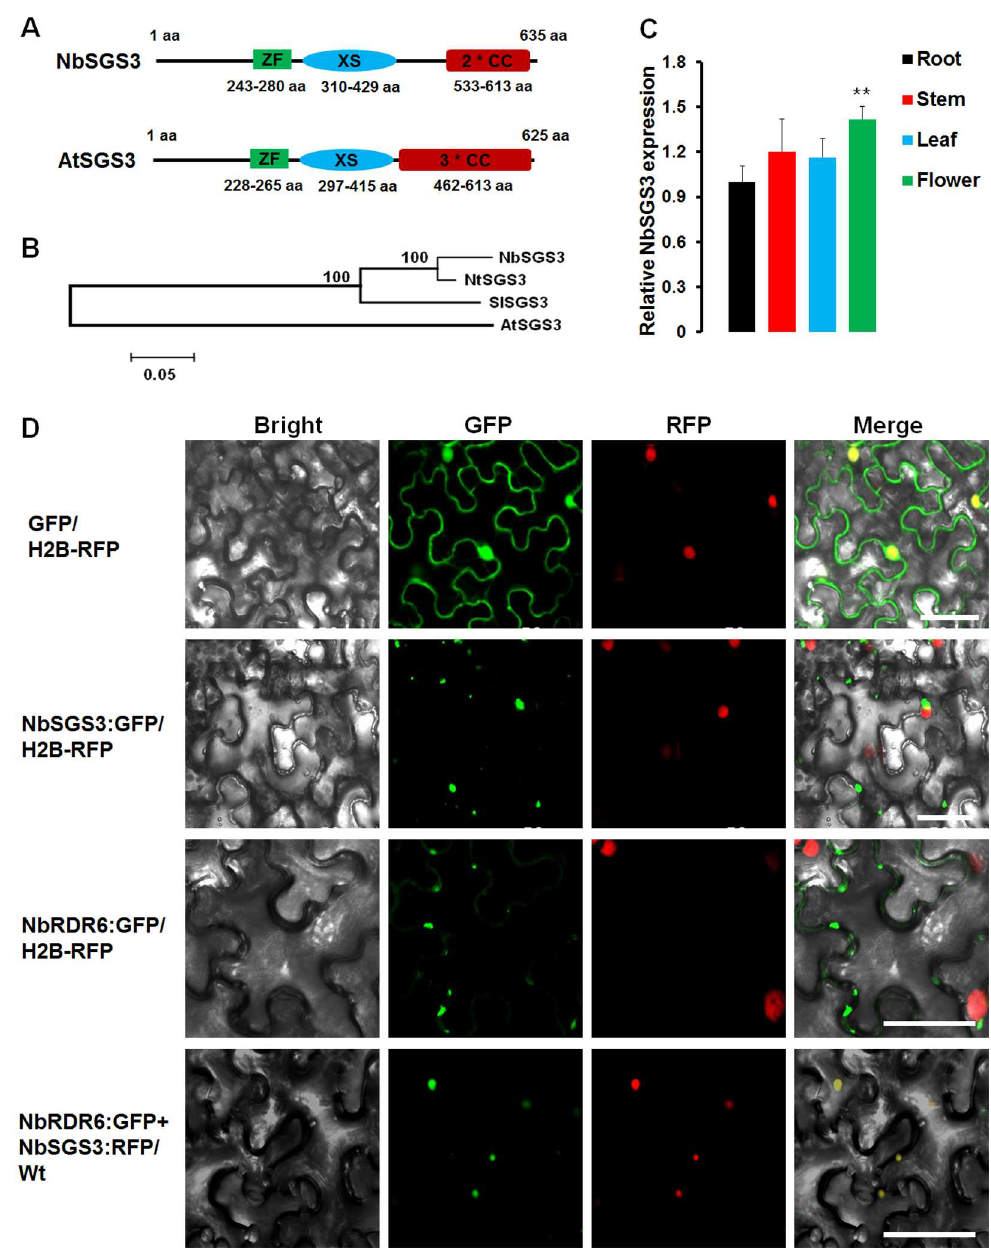
Fig 2. Sequence analysis, expression pattern and subcellular localization of NbSGS3. (A) The lineardiagram representsthe domainstructure of AtSGS3 and NbSGS3, ZF: Zinc finger, XS: Rice proteinX andSGS3, CC: Coiled-coil. (B) Phylogenetic tree showing the evolutionaryrelationships betweenNbSGS3, NtSGS3, SlSGS3 and AtSGS3 proteins.Amino acidsequencealignment was performed in ClustalX2and tree construction was conducted in MEGA6 usingthe NeighbourJoiningmethod. The scalebar representsthe number of changesper site. (C) RT- qPCR analysisof NbSGS3 expression levels in different tissues of N . benthamiana .Expressionwas normalizedto NbGAPDH levels, which serves as an internalstandard. The relativemRNA level of NbSGS3 in root was arbitrarily set to 1. R: Root, S: Stem, L: Leaf, F: Flower. Student’s t test was performedto comparedifferences between root andstem, leaf or flower tissues. Each mean valuewas derivedfrom three independent experiments (n = 9). Values representthe mean ± standarddeviation(SD). Doubleasterisks indicatea highlysignificantdifference (p < 0.01)betweenroot and flower tissues. (D) Micrographs showingcells from leavesof H2B-RFP transgenic N . benthamiana expressing GFP, NbSGS3:GFP or NbRDR6:GFP (panelsin top three rows), or NbRDR6:GFP and NbSGS3:RFPin Wt N . benthamiana (bottom row). Bars = 50 μ m.